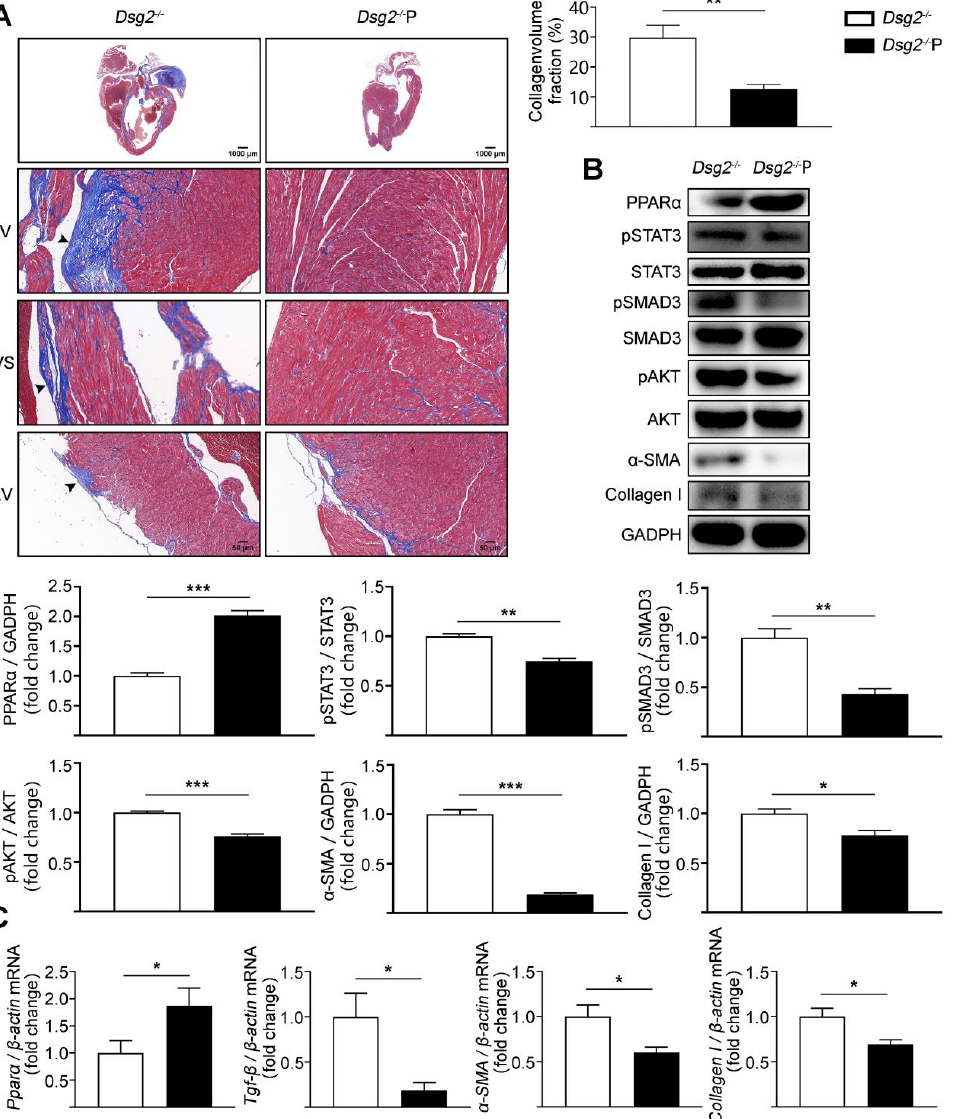
Figure 4. AAV9-Ppar α alleviated cardiac fibrosis in CS-Dsg2 − / − mice. ( A ) Masson staining of heart sections in CS-Dsg2 − / − mice and CS-Dsg2 − / − mice received AAV9-Ppar α (Dsg2 − / − P). Collagen volume fraction in the hearts of CS-Dsg2 − / − and Dsg2 − / − P mice were assessed. ( B ) Representative Western blots from ventricles of CS-Dsg2 − / − and Dsg2 − / − P mice. PPAR α , pSTAT3, pSMAD3, pAKT, α -SMA, and Collagen I were detected using specific antibodies. STAT3, SMAD3, AKT, and GAPDH were used as loading controls. ( C ) Results of quantitative PCR analysis of PPAR α , TGF- β , α -SMA, and Collagen I mRNA levels in mouse ventricles are expressed as fold change of control using β -actin as loading control. Results are expressed as mean values ± SEM. n = 6. * p < 0.05, ** p < 0.01, *** p < 0.001 vs. CS-Dsg2 − / − .